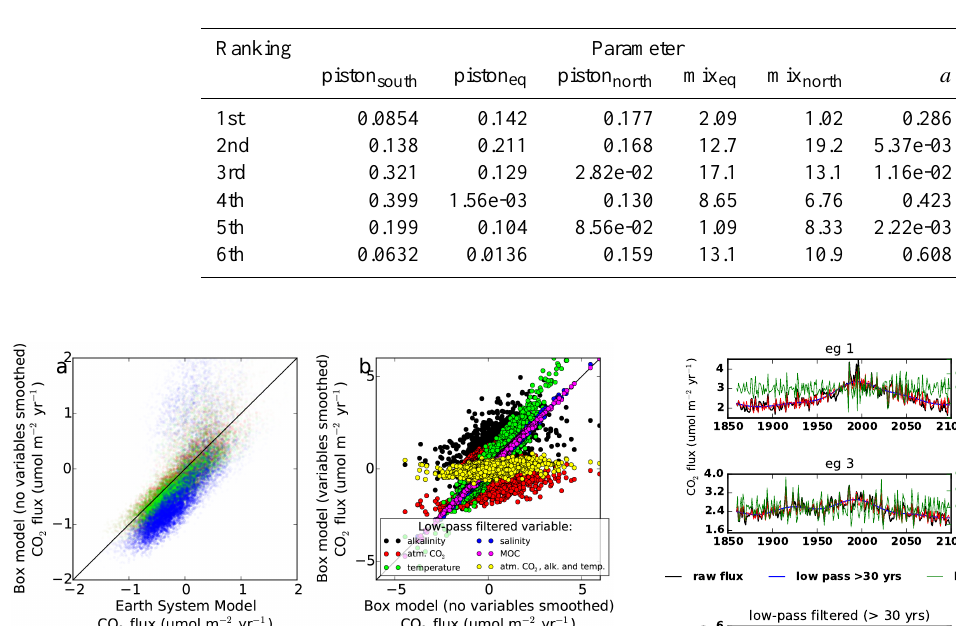
Table 2. Box model parameter values.